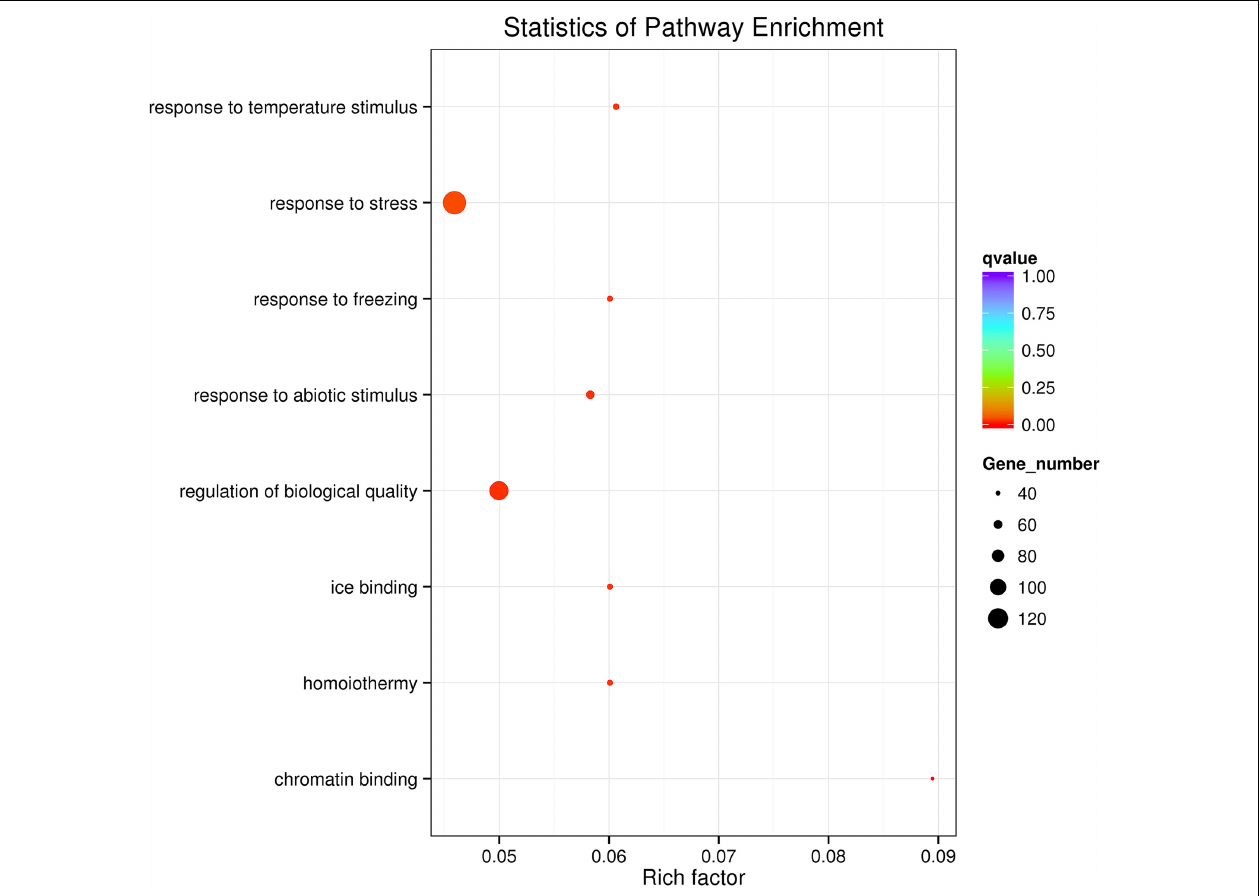
FIGURE 3 | Gene ontology enrichment of P. tenuiflora genes that were positively selected during evolutionary history.